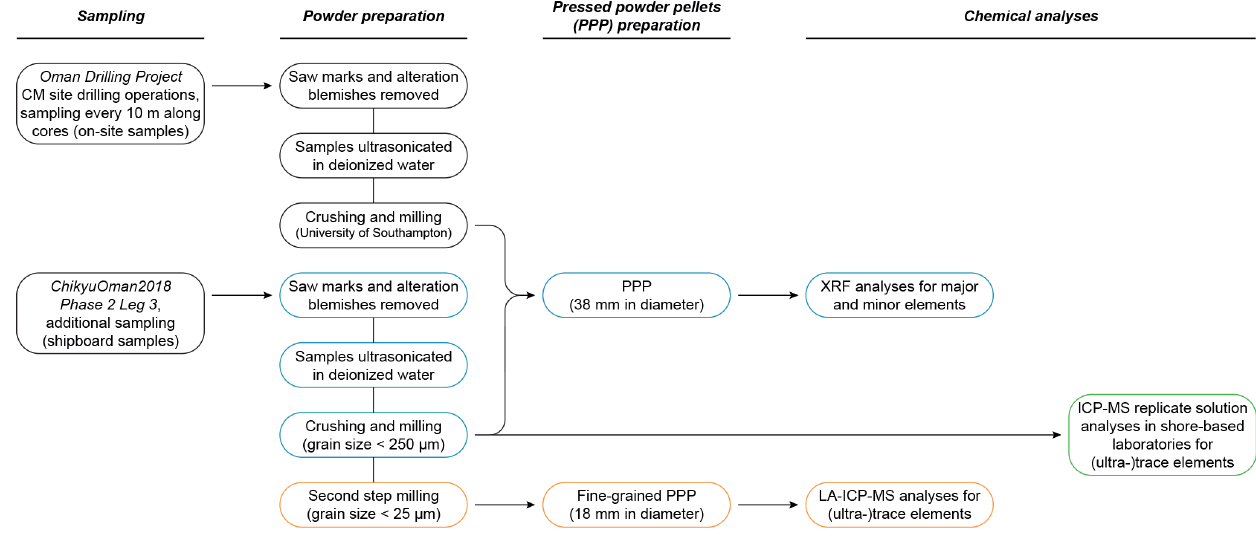
Figure 1. Flow chart summarizing the different steps for sample preparation and chemical